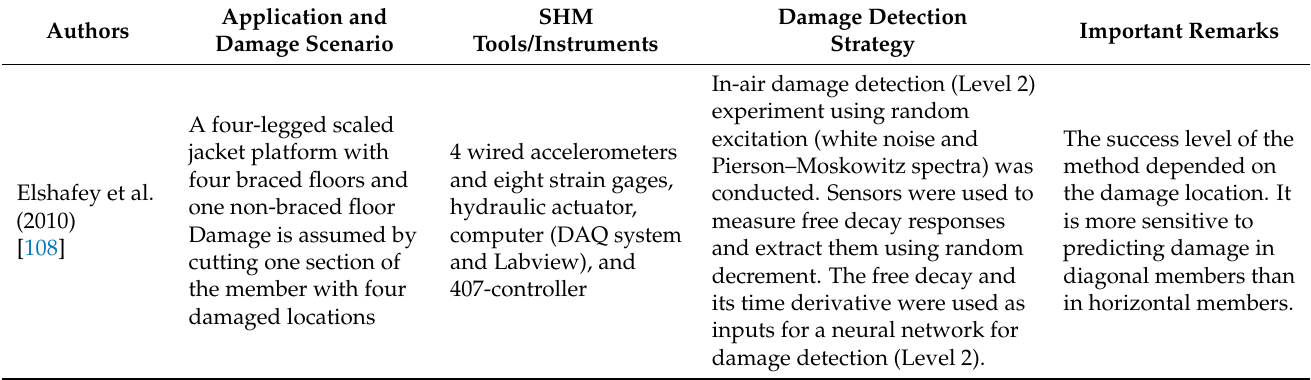
Table 6. Landmark research on the roles of sensors in vibration-based damage detection on offshore